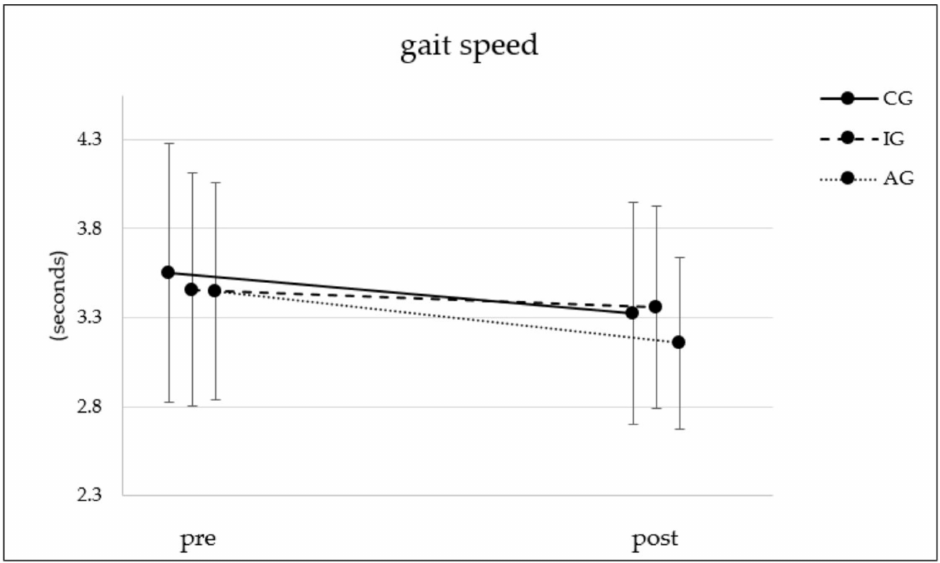
Figure 3. Time (seconds) needed to complete the four-meter walk test. CG = control group; IG = intervention group without activity tracker; AG = activity tracker group receiving the same web-based intervention as the